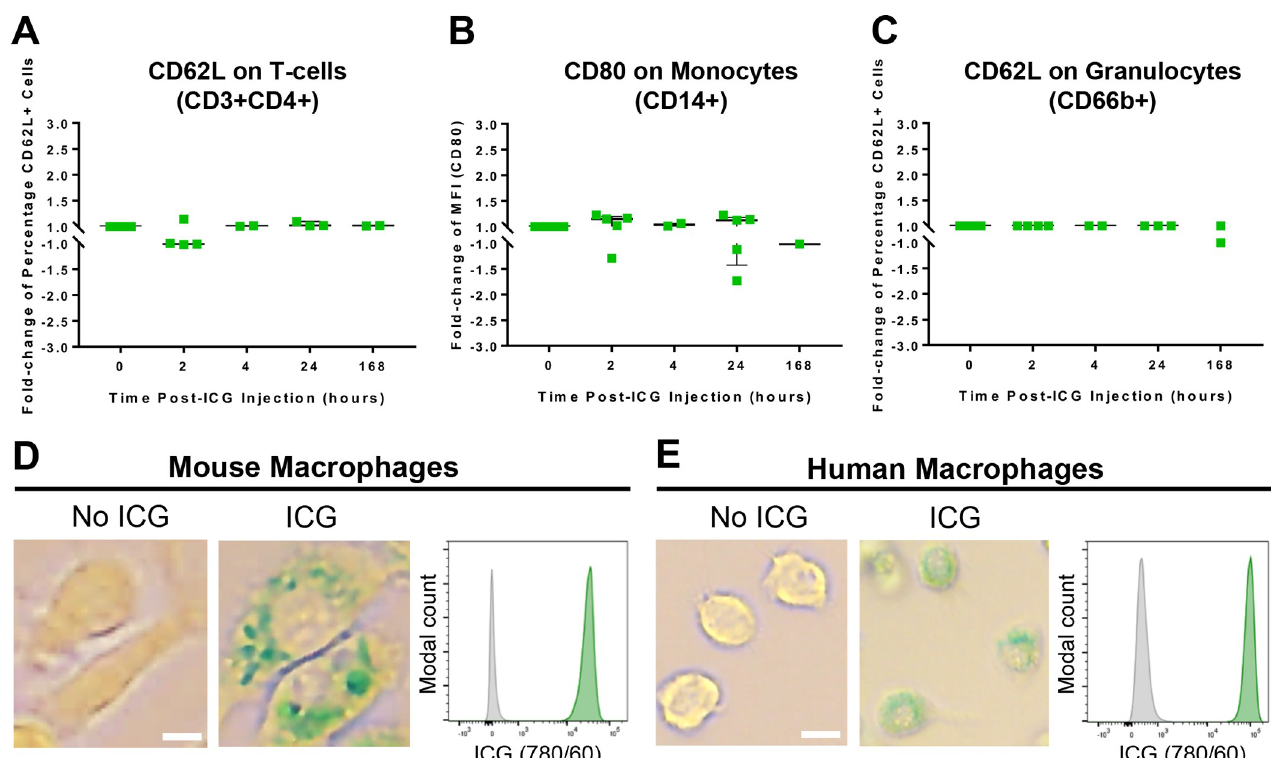
Fig 4. ICG administration did not activate immune cells in peripheral blood but can be observed in endosomes of macrophage cell cultures. (A) Aggregated flow cytometry activation marker changes in participant peripheral blood samples taken across the study are shown measuring CD62L on T-cells (p = 0.914), (B) CD80 on monocytes (p = 0.914), and (C) CD62L on granulocytes (p = 0.698). Each point is a single blood sample from 7 subjects. All activation markers underwent validation with positive control stimuli. Human macrophage cell cultures developed visible signal within endosomes following 24 hours of culture with 0.2 mg/mL ICG by microscopy, which could be detected by flow cytometry in the near infrared channel. (D) Representative images shown for human cell cultures, with (green histogram) and without (grey histogram) ICG administration. Scale bars = 10 μ